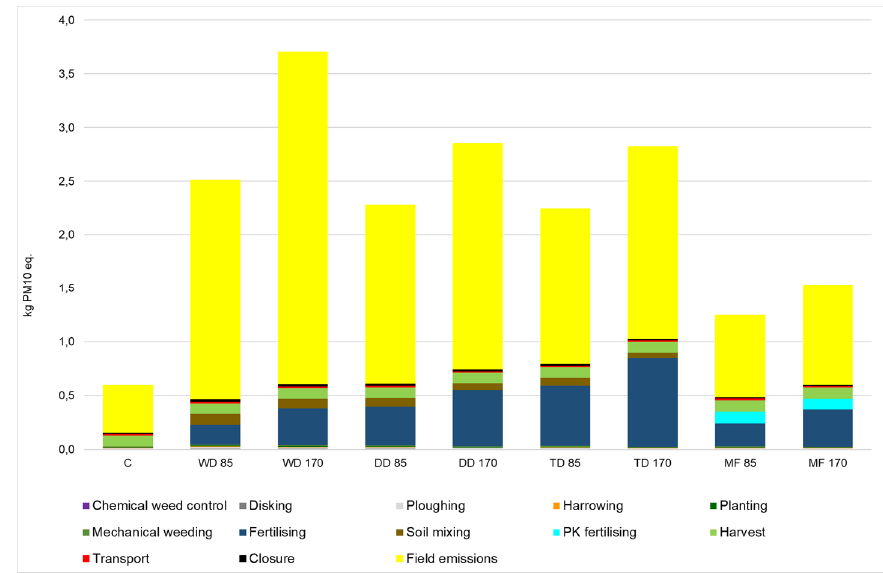
Figure 4. Particulate matter formation per 1 Mg dry matter (d.m.) of miscanthus in different fertilisation treatments.